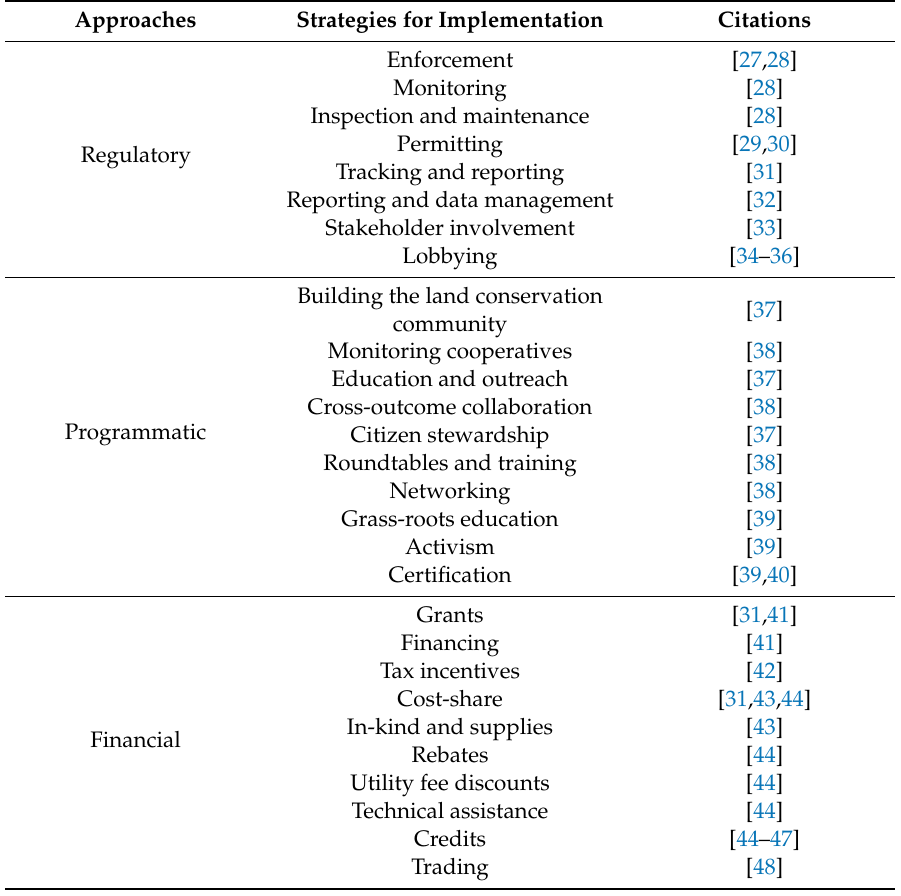
Table 1. Strategies for implementing the regulatory, programmatic, and financial